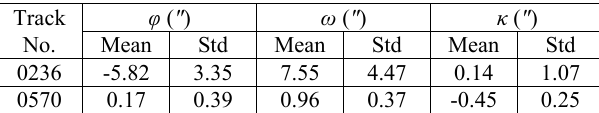
Table 6.Change of pointing elements of exterior orientation